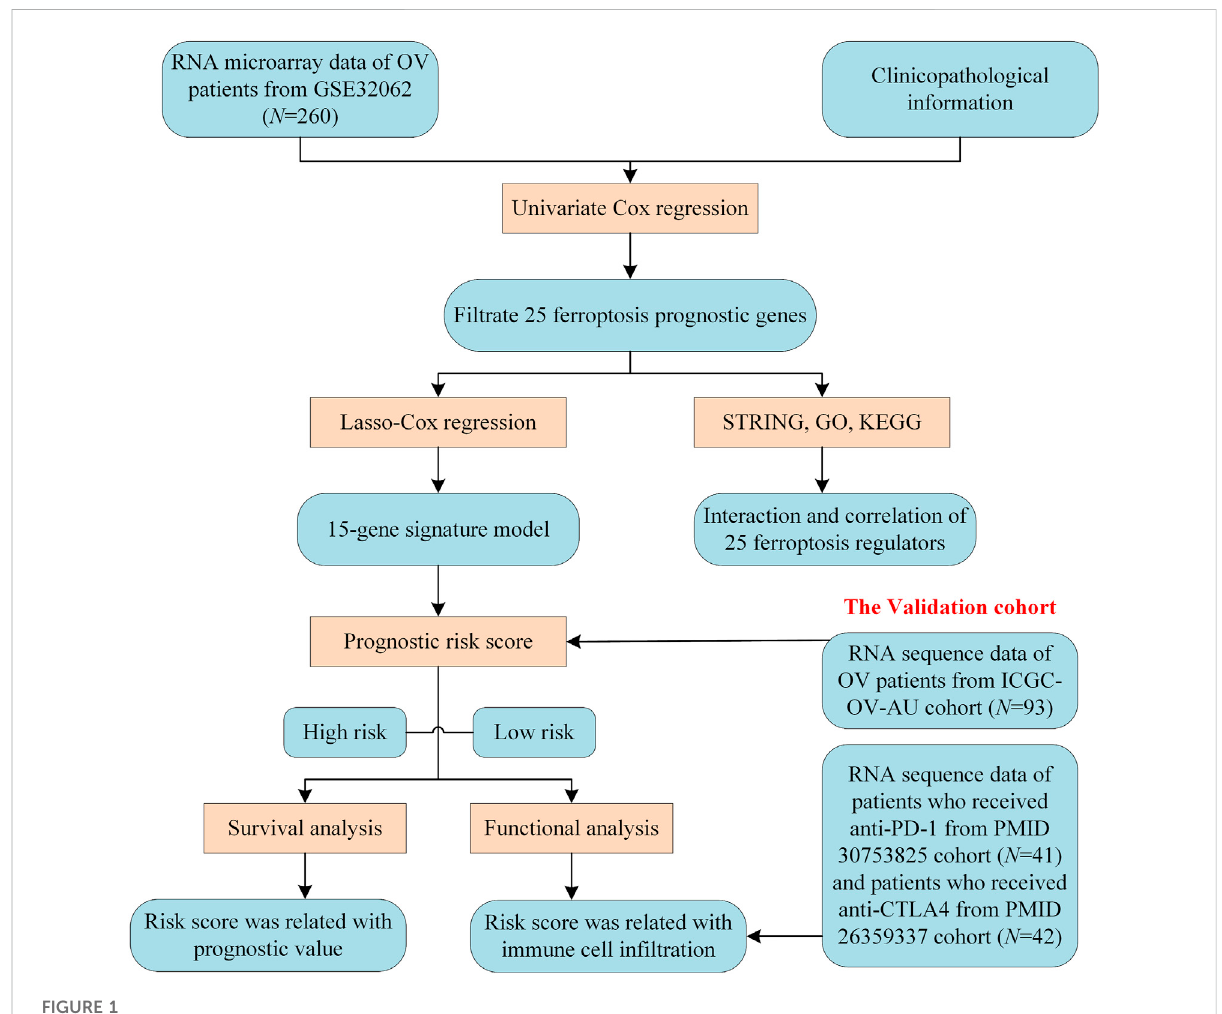
FIGURE 1 Flow chart for cohort collection and bioinformatics